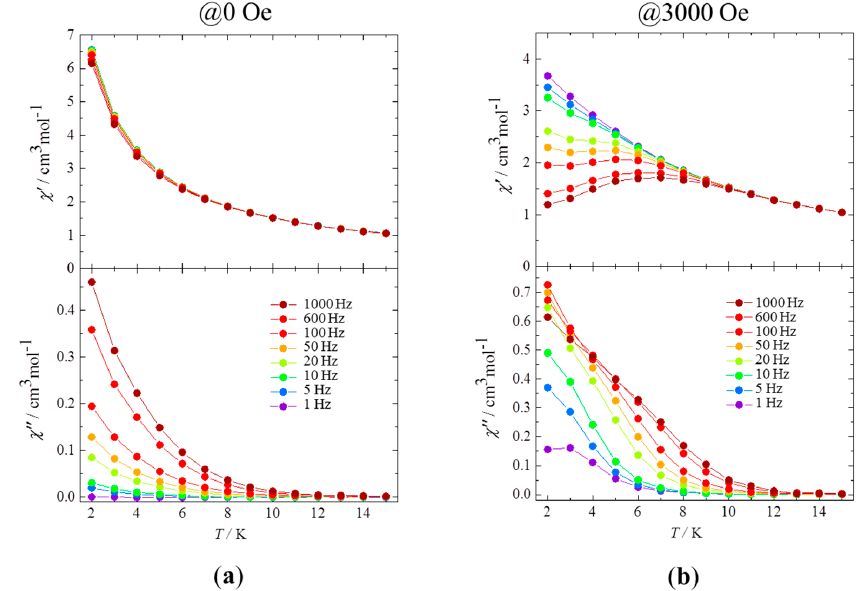
Figure 3. In-phase ( χ′ ) and out-of-phase ( χ′′ ) AC magnetic susceptibilities vs. T plots for 1 in H DC of ( a ) 0 and ( b ) 3000 Oe. The measurements were performed in an H AC of 3 Oe in the frequency range of 1–1000 Hz.